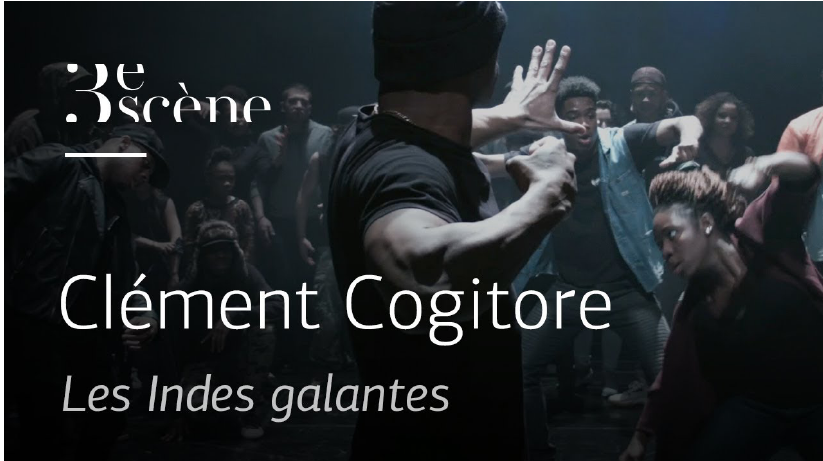
Fig. 7 – Les Indes galantes by Clément Cogitore, Opéra national de Paris YouTube channel, still photo from